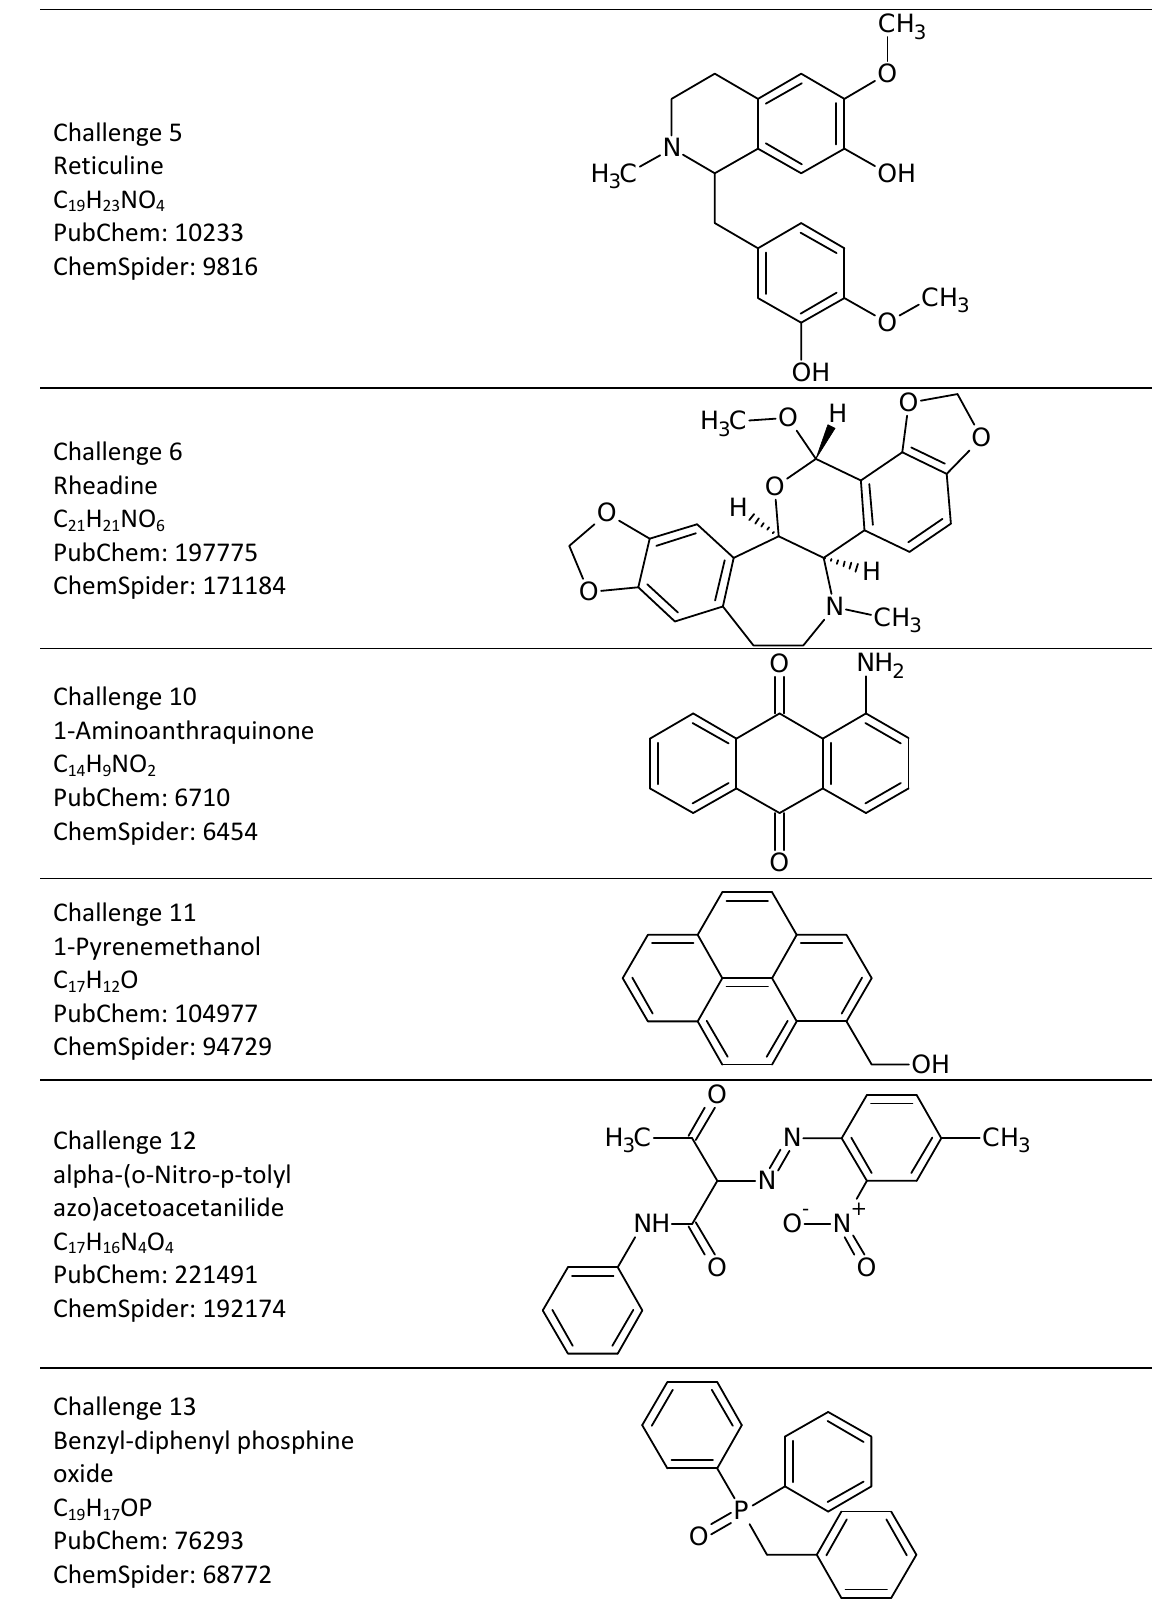
Figure B16. Structures and identifiers for LC-HRMS Challenges